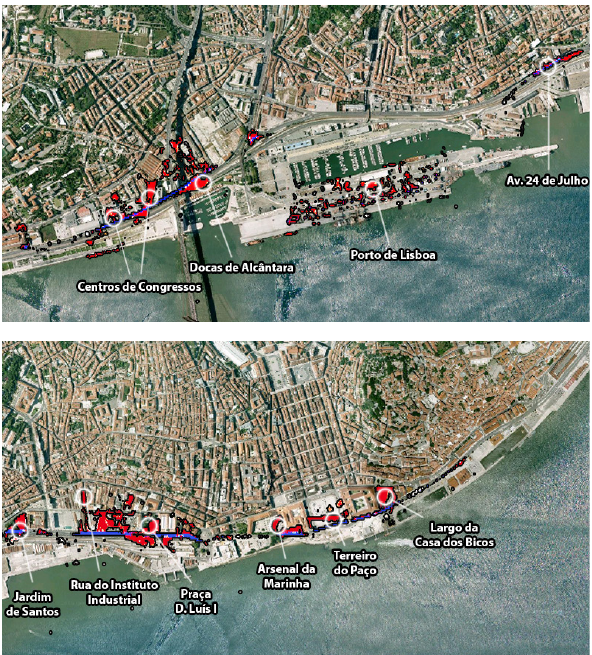
Fig. 13. Final deposition (red) and erosion (blue) patterns at Fig. 13: Final deposition (red) and erosion (blue) patterns at Alcântara (top) and downtown Lisbon Alcantara (center) and Downtown (bottom).